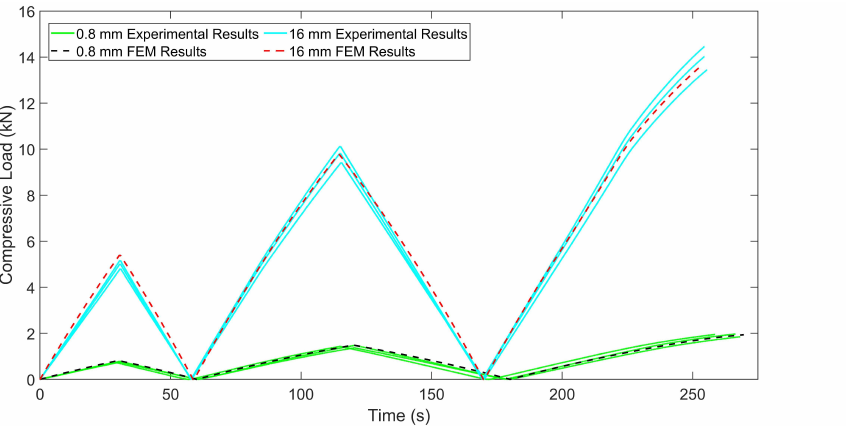
Figure 16. Compressive load profile experimental and numerical results for chiral units with 0.8 mm and 1.6 mm thicknesses.